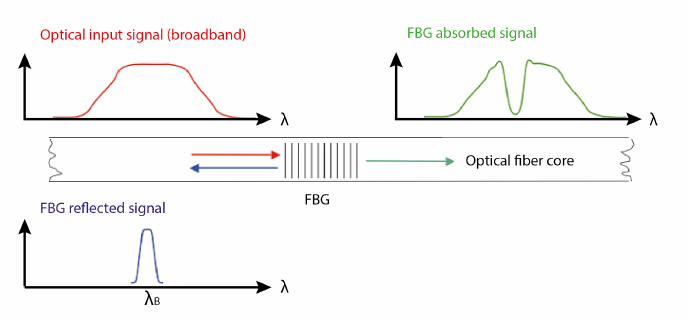
Figure 1. Working process of the FBG technology (image source: https://scienzapertutti.infn.it/ schede-approfondimento/1669-fbg-cosa-sono-e-a-cosa-servono (accessed on 20 July